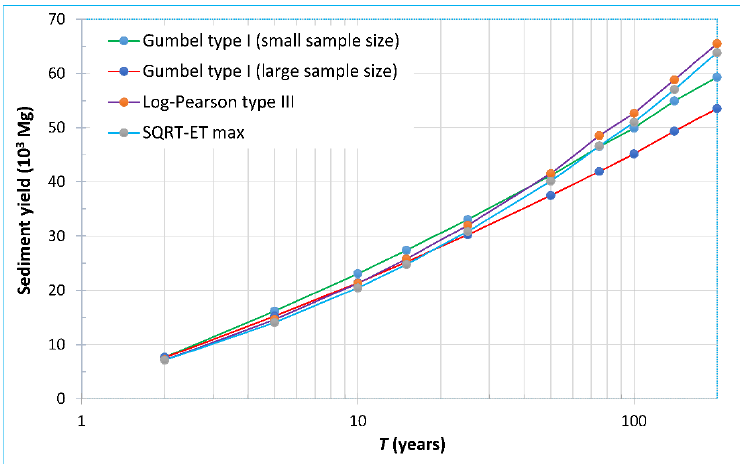
Figure 13. Mean annual sediment yield for the study basin against return period.